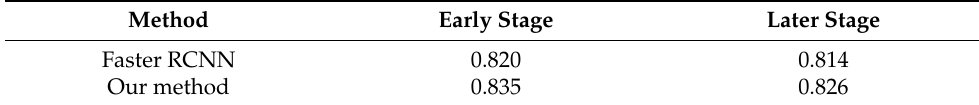
Table 4. IoU of the Two Experiments Classified by Cycle of Construction